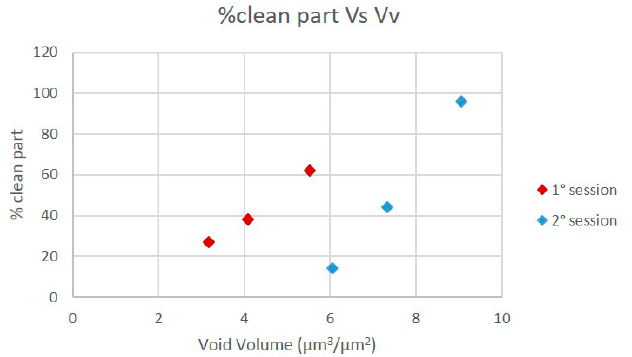
Figure 11. Cleaning efficiency as a function of void volume (Vv) parameters during the campaigns.